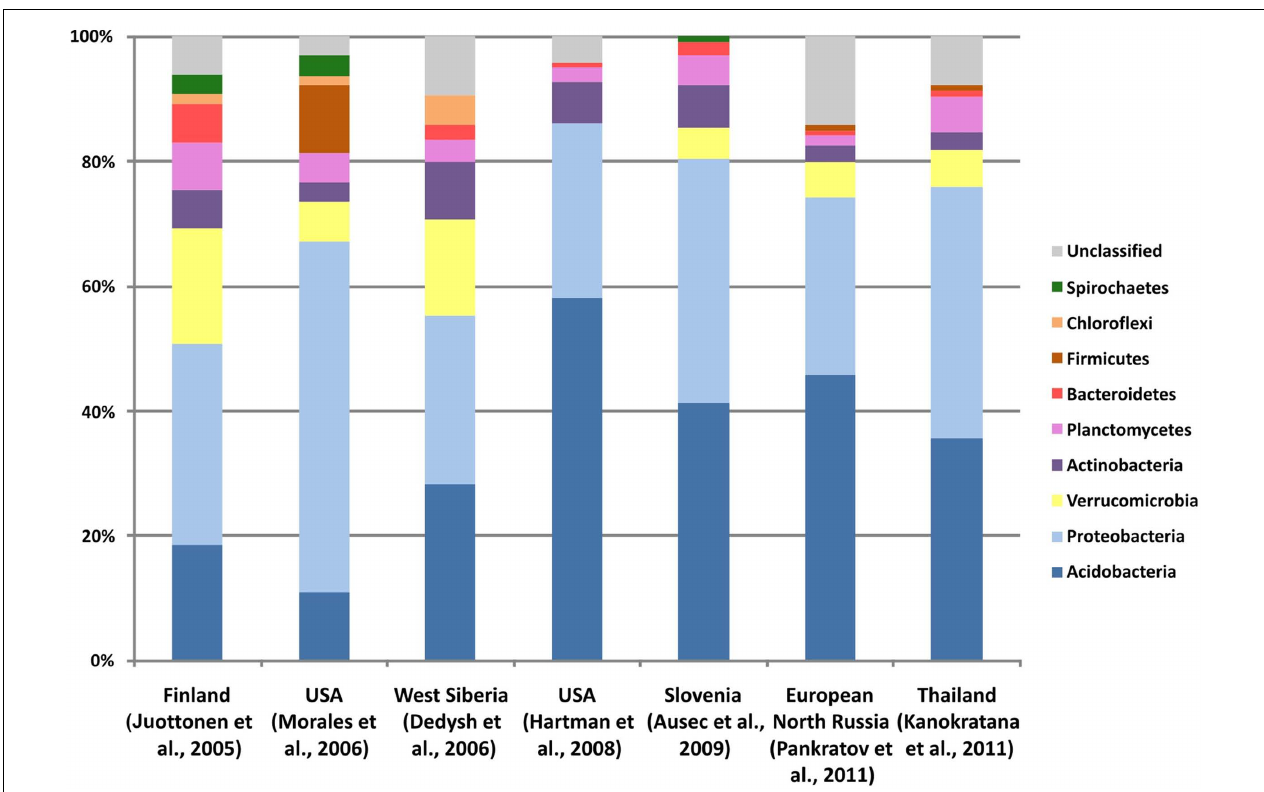
FIGURE 1 |Taxonomic composition of bacterial communities in northern Sphagnum -dominated wetlands of various geographic locations, determined in different cultivation-independent studies (columns 1–6 from left to right) . A dataset obtained for a tropical acidic peatland inThailand (column 7) is included for